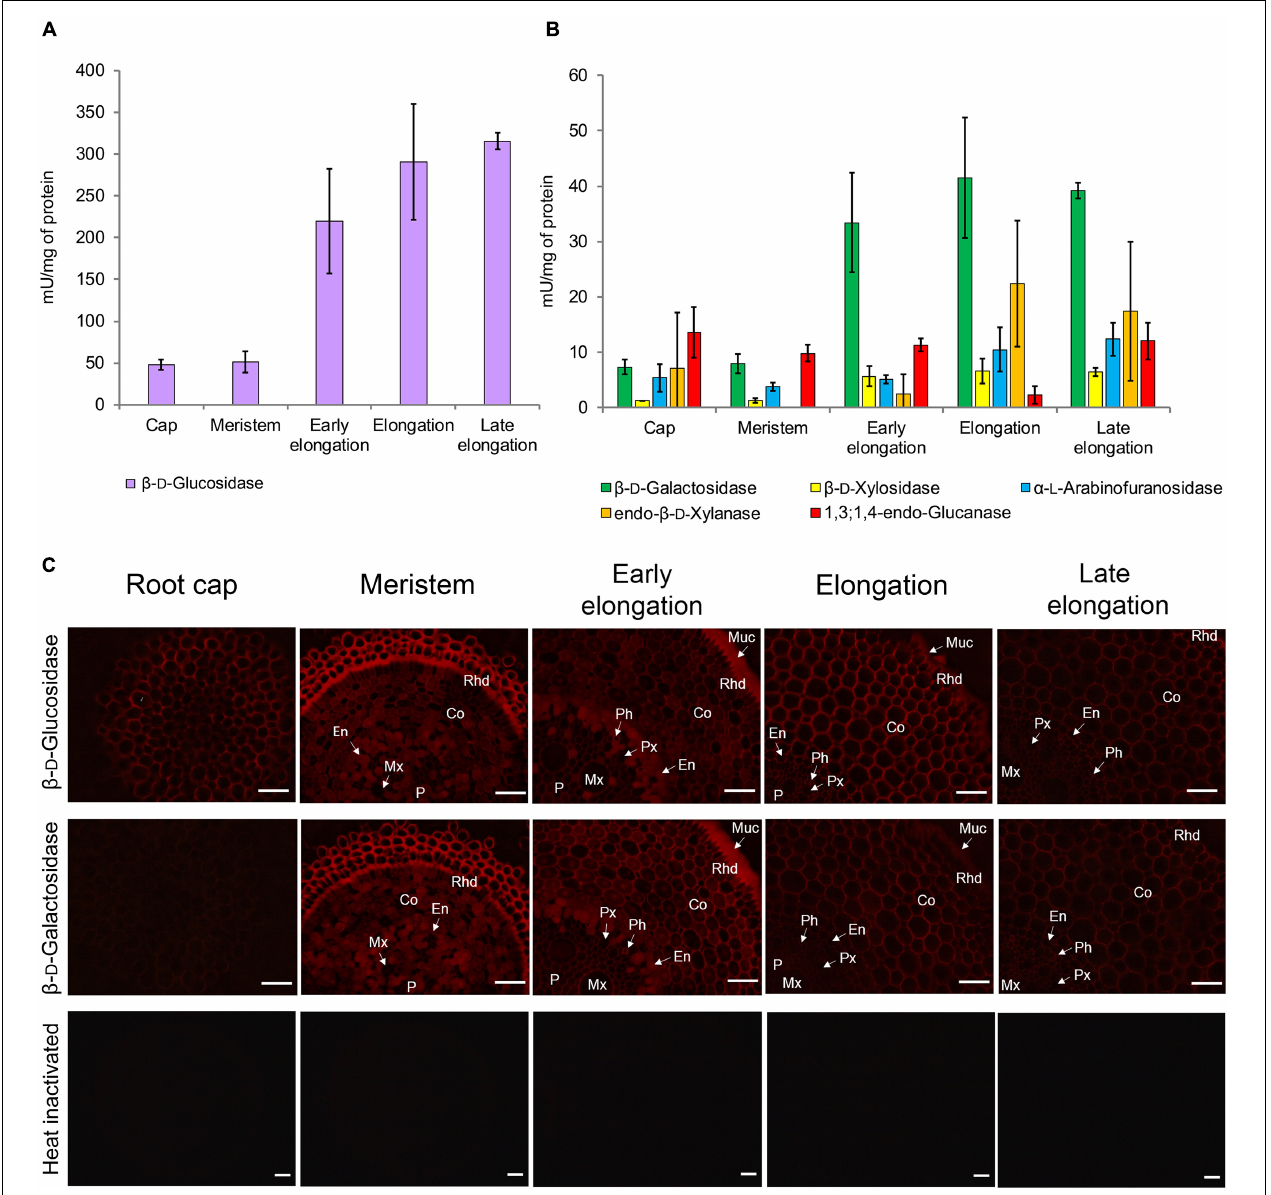
FIGURE 8 | Glycoside hydrolase activities in different zones of maize primary roots assayed in vitro and in situ . (A) The β - D -glucosidase, (B) β - D -galactosidase, β - D -xylosidase, α - L -arabinofuranosidase, xylanase, and 1,3;1,4- β - D -glucan endohydrolase activities measured in clarified homogenates. Values are given as mean ( n = 3) ± SE. (C) The β - D -glucosidase and β - D -galactosidase activities of non-fixed maize primary root cross sections. Co, cortex; En, endodermis; Mx, metaxylem; Muc, mucilage; P, pith; Px, protoxylem; Rhd, rhizodermis. Bars are 50 µ